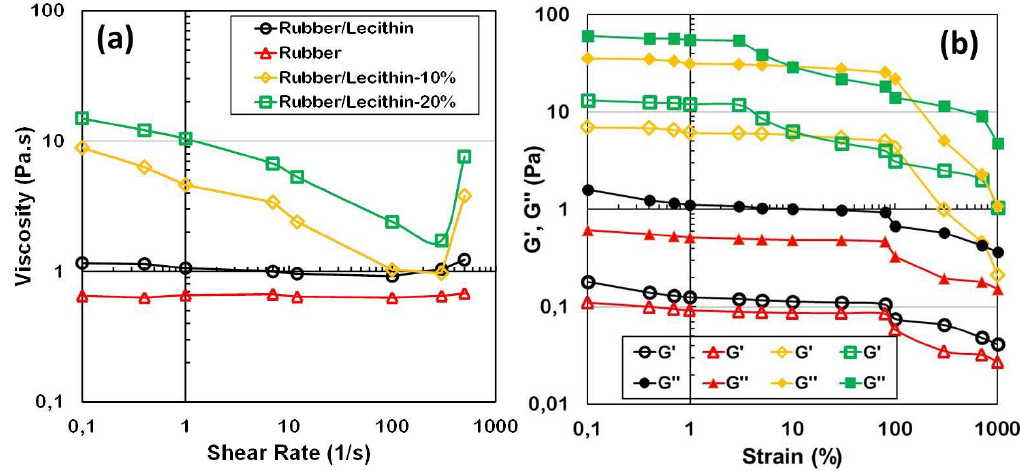
Figure 3. ( a ) Shear rate versus viscosity of selected rubber / lecithin blends and SCCNT-dispersed solutions in MIBK. ( b ) Dynamic rheological response of the same rubber, rubber / lecithin, and SCCNT-dispersed rubber / lecithin suspensions. Note that rubber / lecithin ratio is always kept at 1:1 regardless of the SCCNT concentration. In the legend, for instance, Rubber / Lechitin-10% refers to SCCNT concentration in the polymer blend matrix.